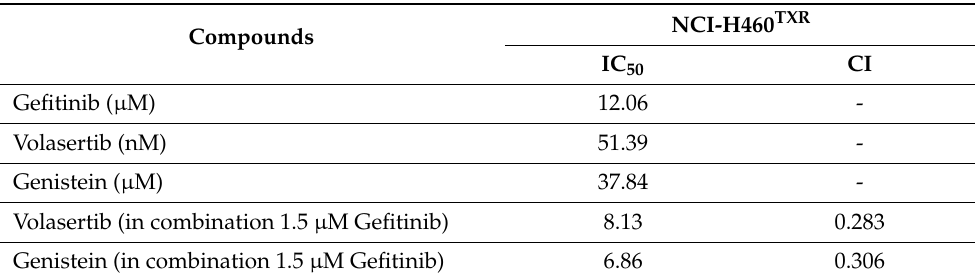
Table 3. The half maximal inhibitory concentration (IC 50 ) values of gefitinib, volasertib, and genistein and the combination index (CI) values when 1.5 µ M of gefitinib (GI 20 ) was combined with volasertib and genistein in NCI-H460 TXR